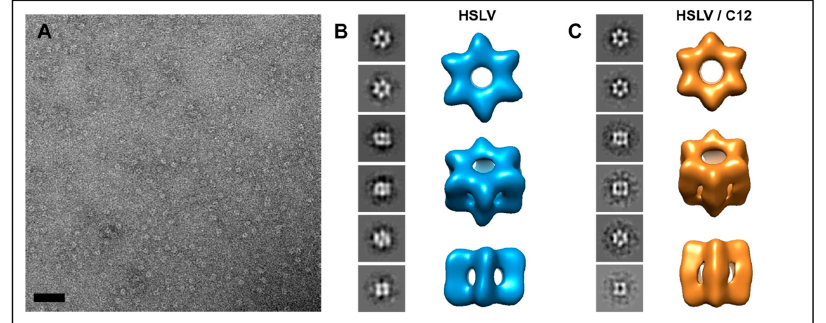
Figure 6. Structural characterization of negatively stained LmHslV and LmHslV-LmC12-U2 particles. ( A ) Field of HslV particles stained with 1% uranyl acetate. Scale bar, 50 nm. ( B ) Selected two-dimensional class averages and 3D reconstruction of HslV. The two first, the two following and the two last views correspond to the top, side and intermediate views, respectively. ( C ) Selected two-dimensional class averages and 3D reconstruction of HslV incubated with LmC12-U2. Selected class averages are presented as in B. Each two-dimensional class average represents a square of 27.6 nm × 27.6 nm.